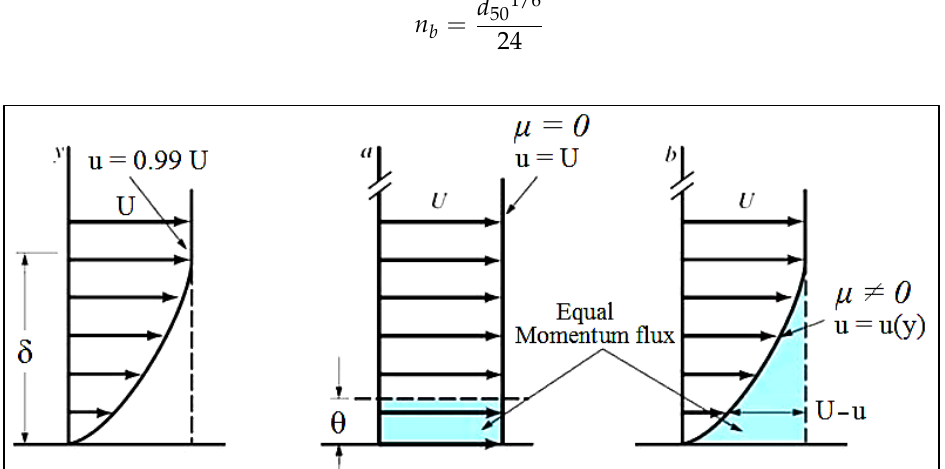
Figure 1. Definition of momentum thickness in a fully developed boundary layer.